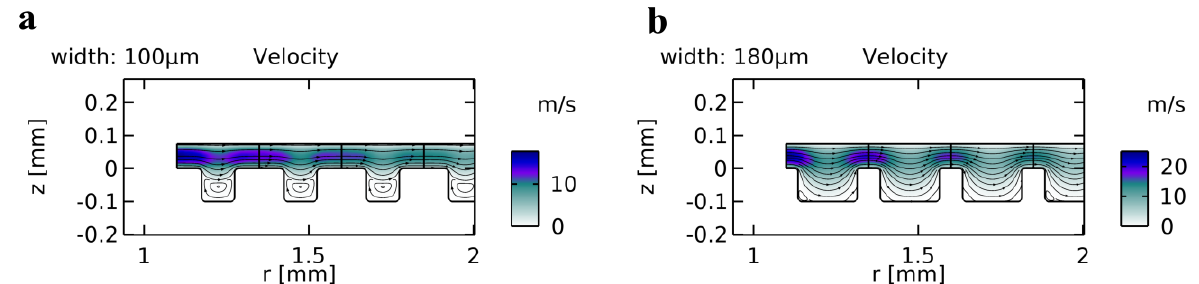
Figure 7. ( a ) Flow field for a width of the trenches of 100 µm. ( b ) Flow field for a width of the trenches of 180 µm, where no vortex generation is observed.